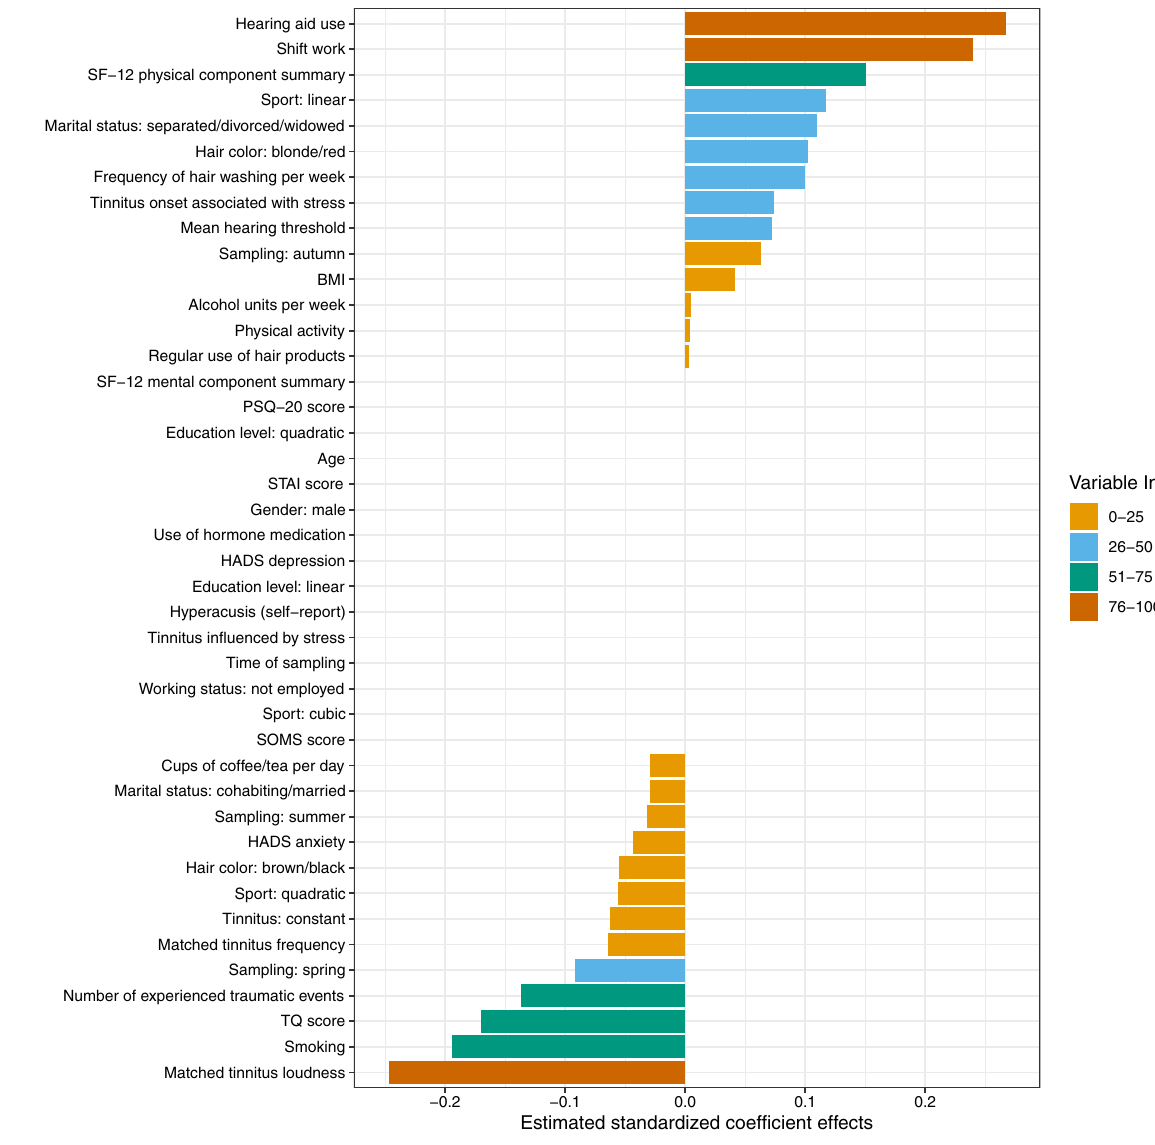
Figure 3. Estimated coefficient effects by elastic net regression with n-fold cross-validation for the prediction of hair-BDNF in chronic tinnitus patients (training data: N = 63). BMI Body-Mass-Index; HADS Hospital Anxiety and Depression Scale; PSQ‑20 Perceived Stress Questionnaire (20 item version); SF‑12 Short Form-12 Health Survey; SOMS Screening of Somatoform Disorders, STAI State-Trait Anxiety Inventory (State Anxiety); TQ Tinnitus